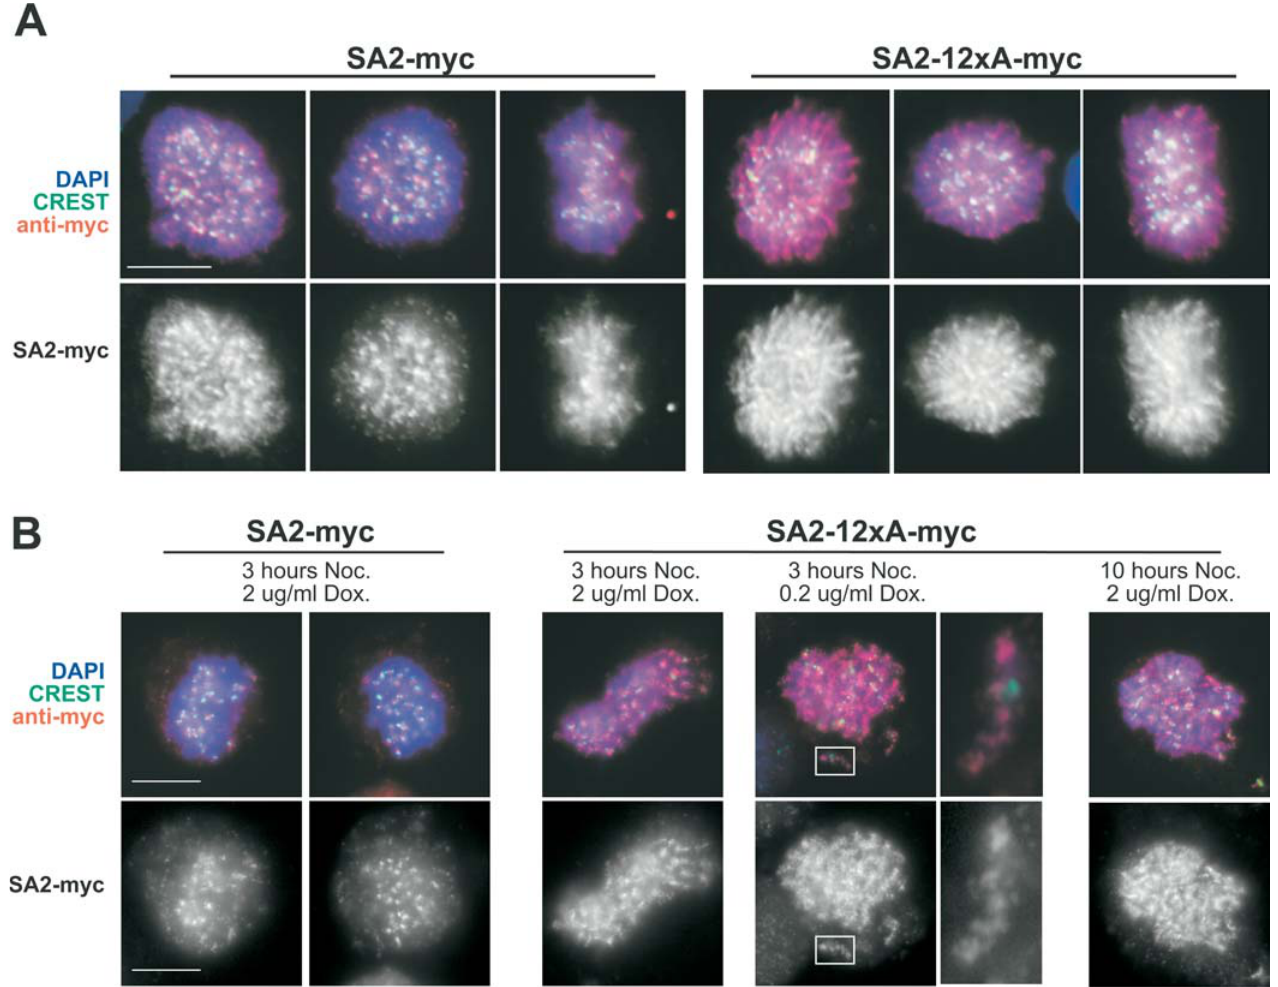
Figure 5. Phosphorylation of SA2 Is Required for Cohesin Dissociation from Chromosome Arms during Prometaphase (A) Logarithmically proliferating HeLa cells expressing SA2-WT-myc or SA2–12xA-myc were extracted prior to fixation, and stained with myc antibodies. In the upper set of images, kinetochores were labeled with human CREST serum, and DNA was counterstained with DAPI. In the lower set of images, only SA2-myc staining is shown. (B) SA2-myc expression was induced by different amounts of doxycycline (Dox.), and cells were arrested in prometaphase by nocodazole (Noc.) treatment for 3 or 10 h. Cells were spun on glass slides, extracted by detergent, fixed, and processed for immunostaining as in (A). Scale bars 10 l m. DOI: 10.1371/journal.pbio.0030069.g005